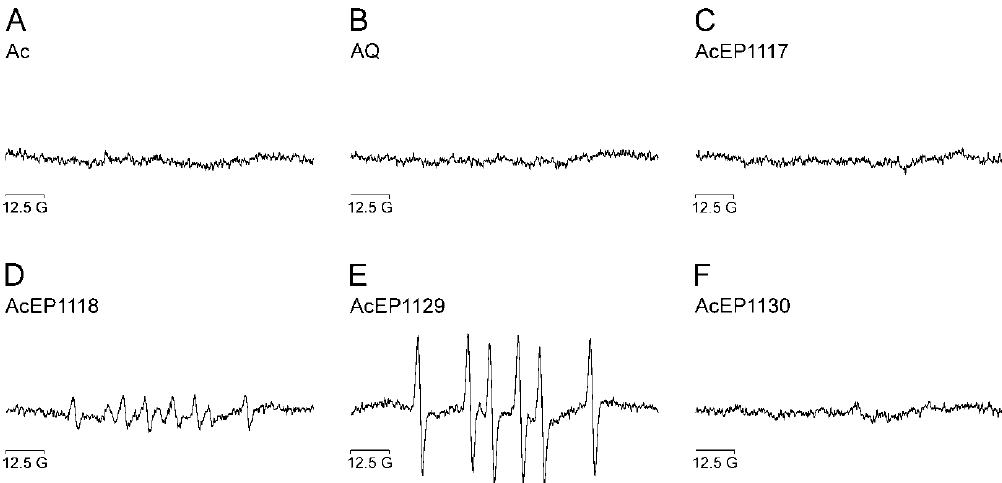
Figure 3. EPR spectra obtained after activation of AcEPs in Leishmania in the presence of the spin trap DMPO. The spectra shown were obtained after incubation of LtP (2 × 10 9 LtP/mL) for 15 min with 500 µM of ( A ) anthracene (Ac), ( B ) anthraquinone (AQ), ( C ) AcEP1117, ( D ) AcEP1118, ( E ) AcEP1129 or ( F ) AcEP1130 in the presence of 40 mM DMPO. The maximum concentration of the vehicle (DMSO) was 1.27%. Reactions were performed in a mixture of PBS and glucose (15 mM) at 25 °C. The graph shows representative spectra of three independent experiments.